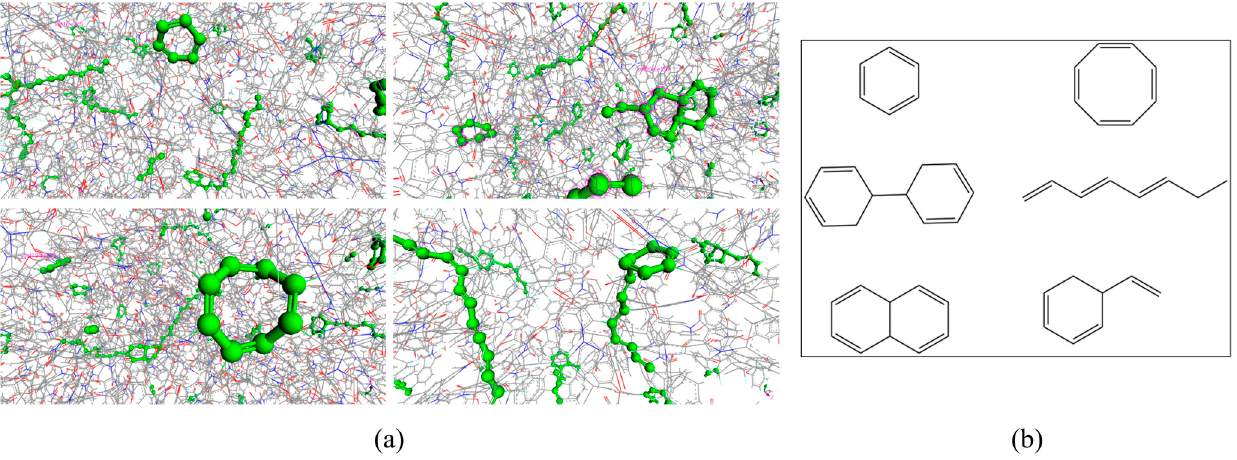
Figure 4. ( a ) The partial structures of the ODPA-APB cross-linked PI resin: in order to distinguish the changes of the molecular model before and after cross-linking, the linear model is used to represent the atoms that do not participate in the crosslinking reaction, and the spherical model is used to represent the cross-linked covalent bond formed. ( b ) Important structural fragments formed by the cross-linking of three bond carbon atoms in the phenylethynyl group.